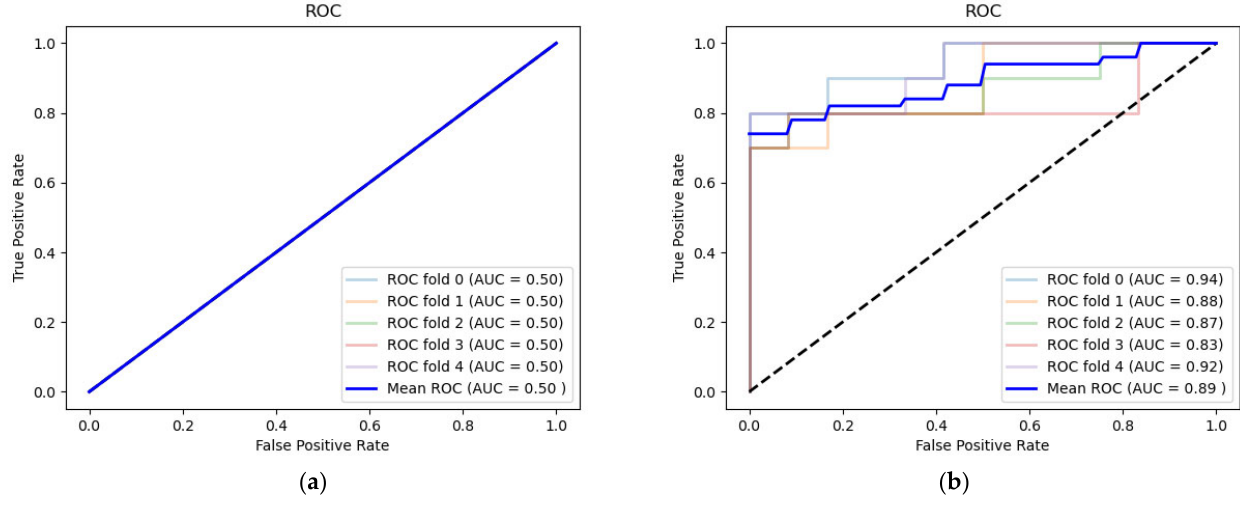
Figure 6. ROC curve of DNN: ( a ) non ‐ feature selection; ( b ) GA1.